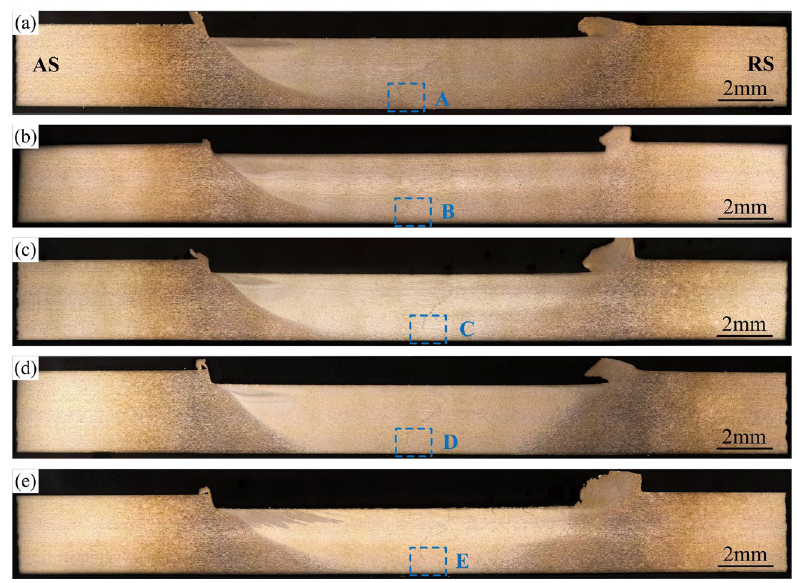
Figure 9. Weld transverse cross-sections to various rotation speeds: ( a ) ω = 600 rpm; ( b ) ω = 700 rpm; ( c ) ω = 800 rpm; ( d ) ω = 900 rpm; ( e ) ω = 1000 rpm; ( v = 30 mm/min, d = 12 mm).